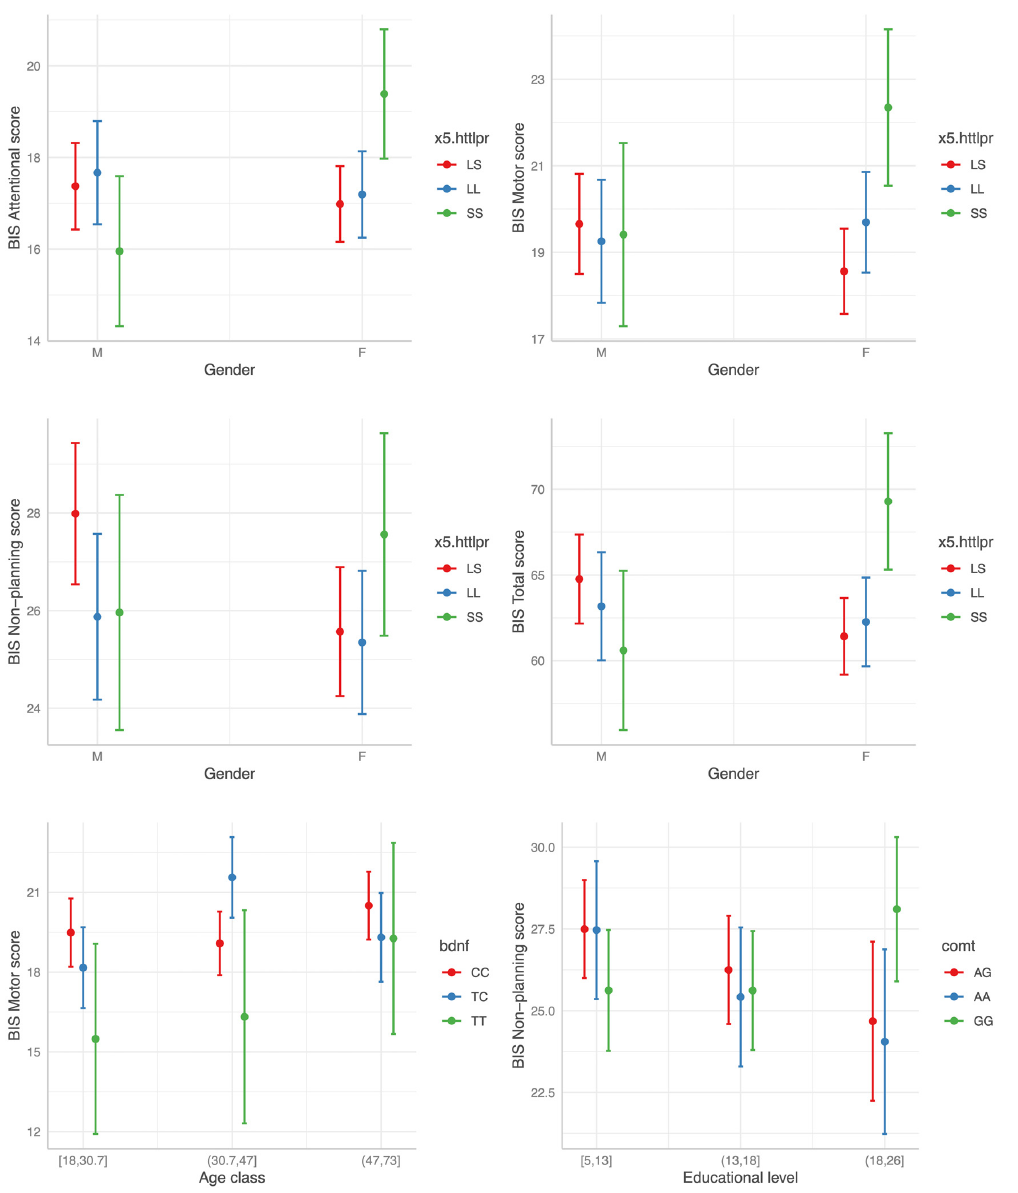
Figure 4. The interaction effect between polymorphism status and gender, age and educational level (from top left to bottom right) on BIS